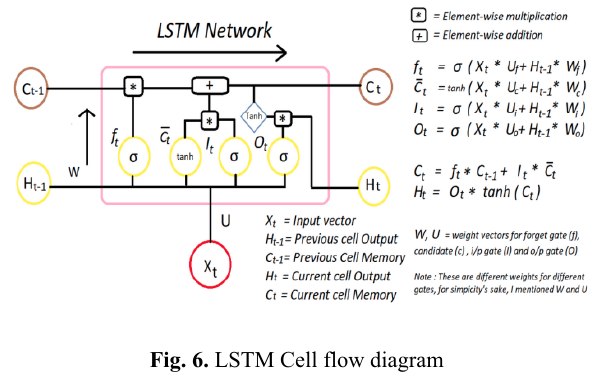
Fig. 6. LSTM Cell flow diagram Table 2. Model History